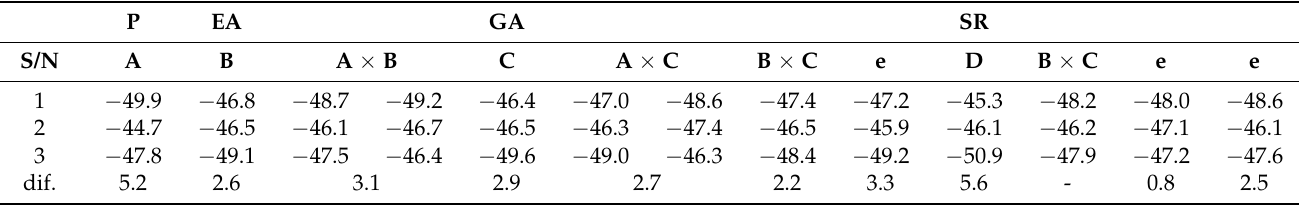
Table 4. Mean values of S/N index and maximum differences between levels on CO.